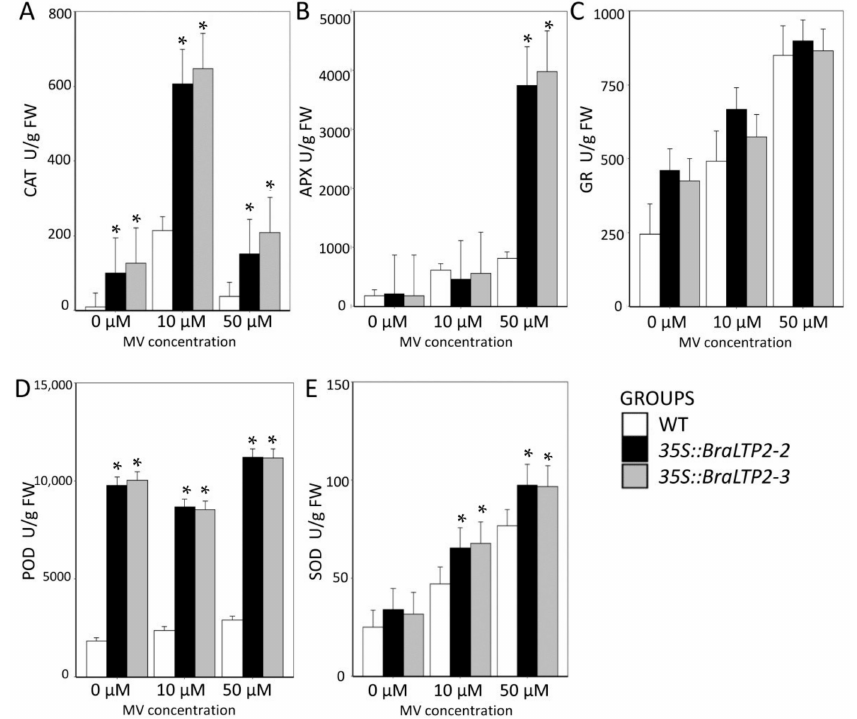
Figure 7. Changes in activities of antioxidant enzymes of WT, 35S::BraLTP2 -2, and 35S::BraLTP2 -3 leaves. The activity of antioxidant enzymes was determined after treatment with methyl viologen (MV) for four hours. * Statistically significant difference from wild type ( * p < 0.05) in each different treatment. Experiments were performed in triplicate. ( A ): CAT—Catalase; ( B ): APX—Ascorbate peroxidase; ( C ): GR—Glutathione reductase; ( D ): POD—Peroxidase; and ( E ): SOD—Super oxide